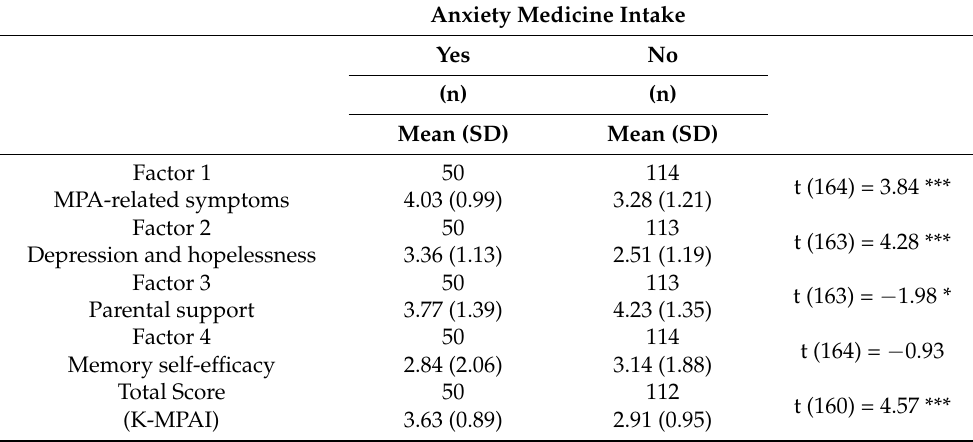
Table 6. Differences between participants with and without a history of medicine intake to manage anxiety symptoms (dimensions and total